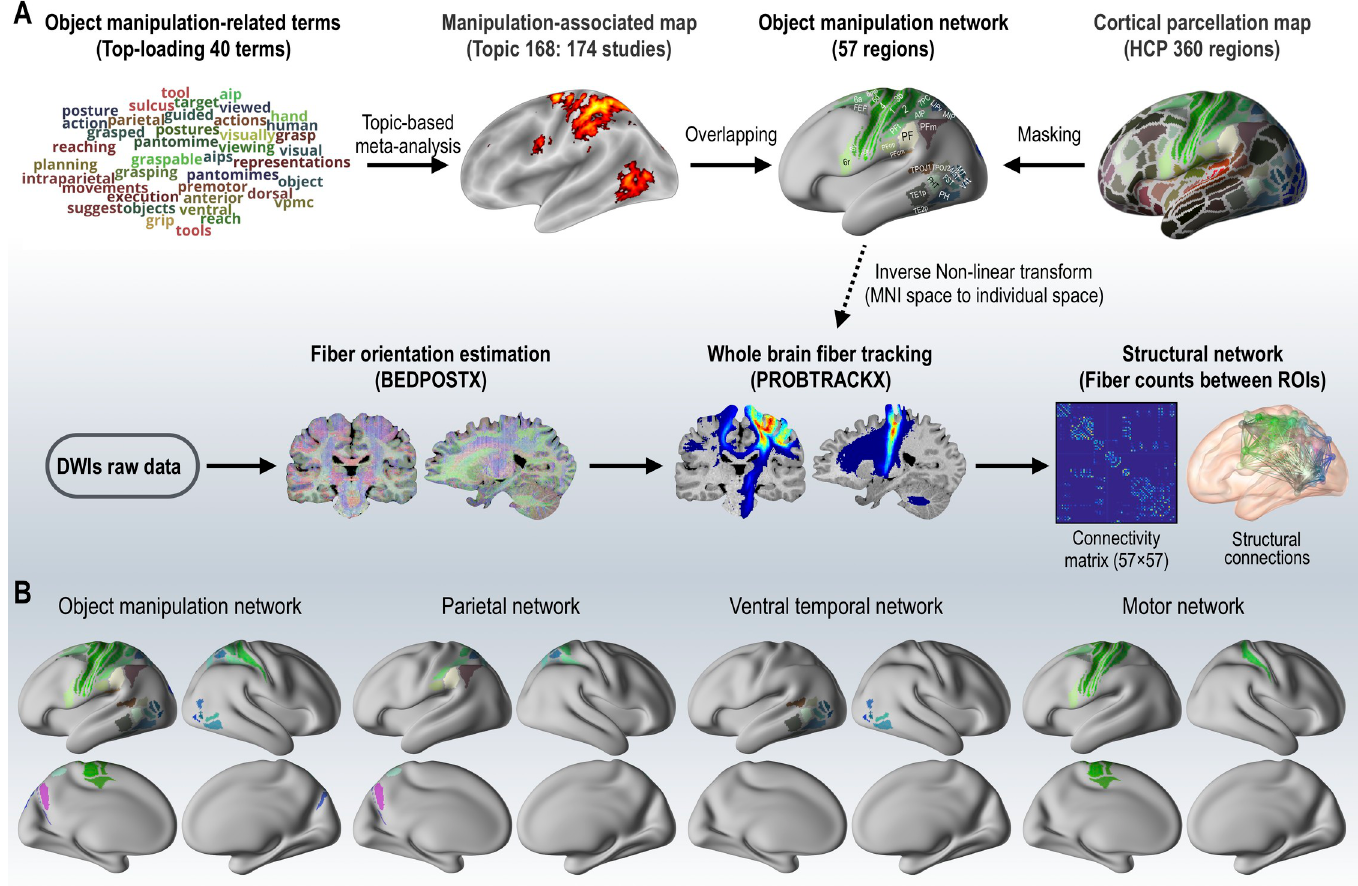
Fig 1. Data selection and processing. (A) An overview of the meta-analysis procedure to derive the object manipulation network and its structural network construction. FEF, frontal eye fields; 6a, area 6 anterior; 6mp, area 6mp (supplementary motor area); 6d, dorsal area 6; 6r, rostral area 6; 6v, ventral premotor cortex 6; 4, primary motor cortex; 3a, area 3a; 3b, primary sensory cortex; 1, area 1; 2, area 2; PFt, PFt area; Pfop, PF opercular area; PF, PF area (Brodmann Area 40); PFm, PF Complex area; 7PC, Area 7PC; AIP, anterior intraparietal area; LIPv, ventral lateral intraparietal area; MIP, medial intraparietal Area; TPOJ1, temporo-parieto-occipital junction 1 area; TPOJ2, temporo-parieto-occipital junction 2 area; TE1p, posterior TE1 area; TE2p, posterior TE2 area; PHT, PHT area; PH, PH area; FST, FST area; MST, medial superior temporal Area; MT, middle temporal Area; V4t, V4t area. (B) Construction of the object manipulation network and its subnetwork regions. L, left; R, right; BEDPOSTX, Bayesian estimation of diffusion parameters obtained using sampling techniques; PROBTRACKX, probabilistic tracking with crossing fibers. preprocessed using FMRIB’s diffusion toolbox (FDT v3.0, http://fsl.fmrib.ox.ac.uk/fsl/fslwiki/ FDT) as far as the Bayesian estimation of diffusion parameters obtained using sampling tech- niques (BEDPOSTX), following the HCP Diffusion pipeline [60, 61]. We conducted probabi- listic tracking with crossing fibers (PROBTRACKX) to generate probabilistic connections using the preprocessed DTI data. The probabilistic tracking parameters were as follows: 5,000 samples within each voxel, 0.2 curvature threshold, 0.5-mm step length, and 2,000 steps per sample. The structural connectivity between tool-preferring regions was calculated by the number of probabilistic streamlines projecting from one tool-preferring region to another. Since the brain region sizes differ between males and females [62], presumably leading to dif- ferences in the structural connectivity, the probabilistic streamlines were normalized by the size of the seed region of interest. The normalized probabilistic streamlines were used to con- struct a structural matrix for each participant, without thresholding for the object manipula- tion network.